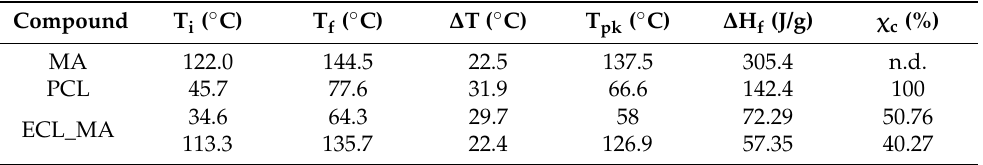
Table 5. Differential scanning calorimetry (DSC) parameters of the ECL_MA co-polyesters, PCL homopolymer, and MA monomer.